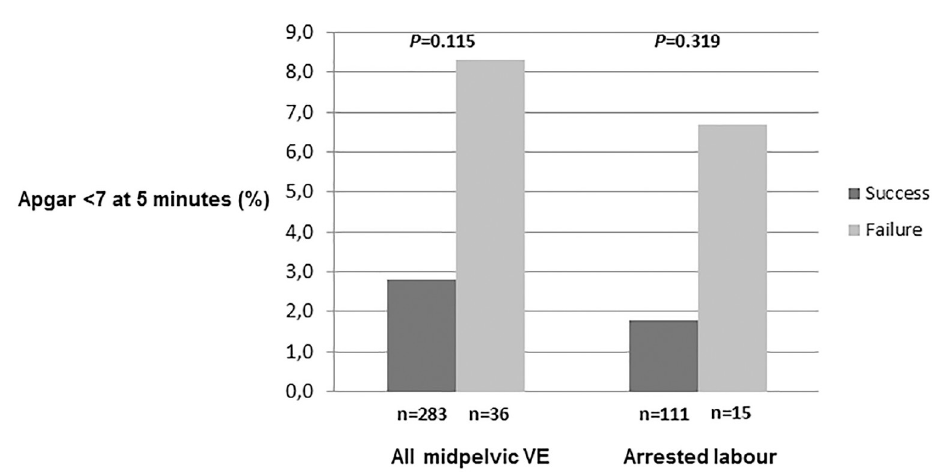
Fig 2. Proportion of neonates with Apgar < 7 at 5 minutes (%) according to success or failure of attempted midpelvic vacuum and delivery indication “arrested labour”. VE, Vacuum extractions. Multiple imputation did not change the significance of any results (Table 3 and S2